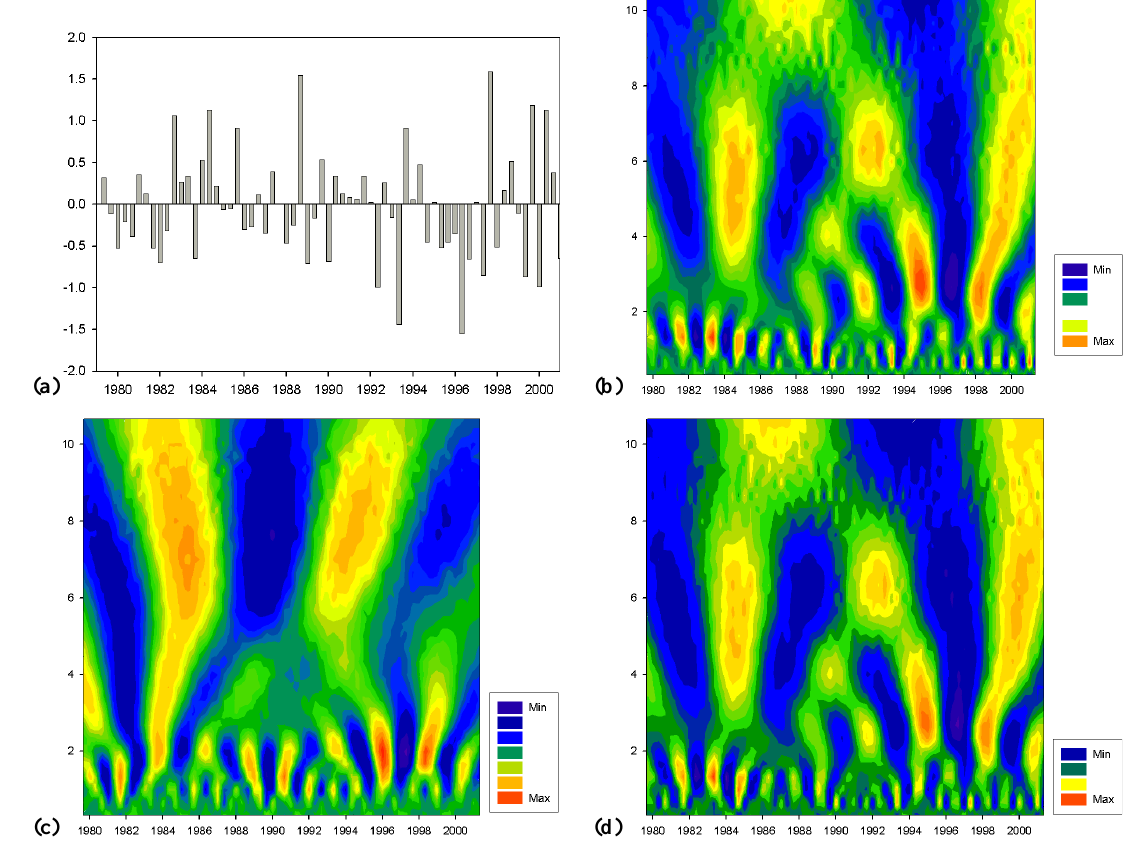
Fig. 3. (a) Standardized wind gust time series spatially and temporally (March-May) averaged over Iberia. Units are in standard deviations in the y-axis and the x-axis corresponds to the time period. The wavelet power spectrum (dimensionless) of the: (b) standardized wind gust time series displayed in (a); and (c) spring SCAND index and (d) wind gust expansion coefficient time series corresponding to Fig. 2c (continuous line). The y-axis represents the variability scale (years) and the x-axis corresponds to the time period. This figure is available in colour